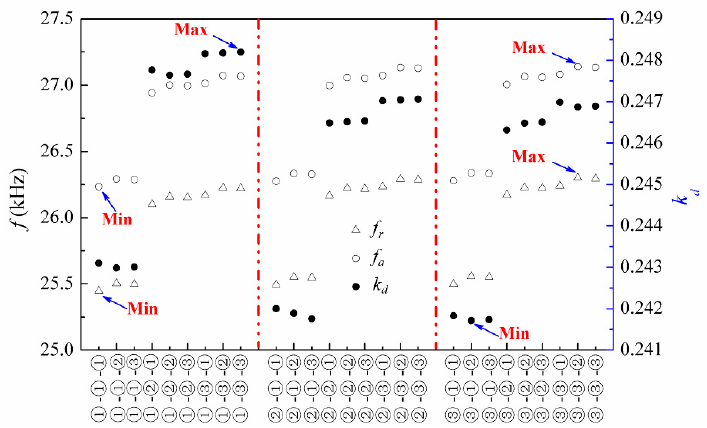
Figure 6. Electromechanical characteristics of the transducers with different material sequences of the epoxy layers.